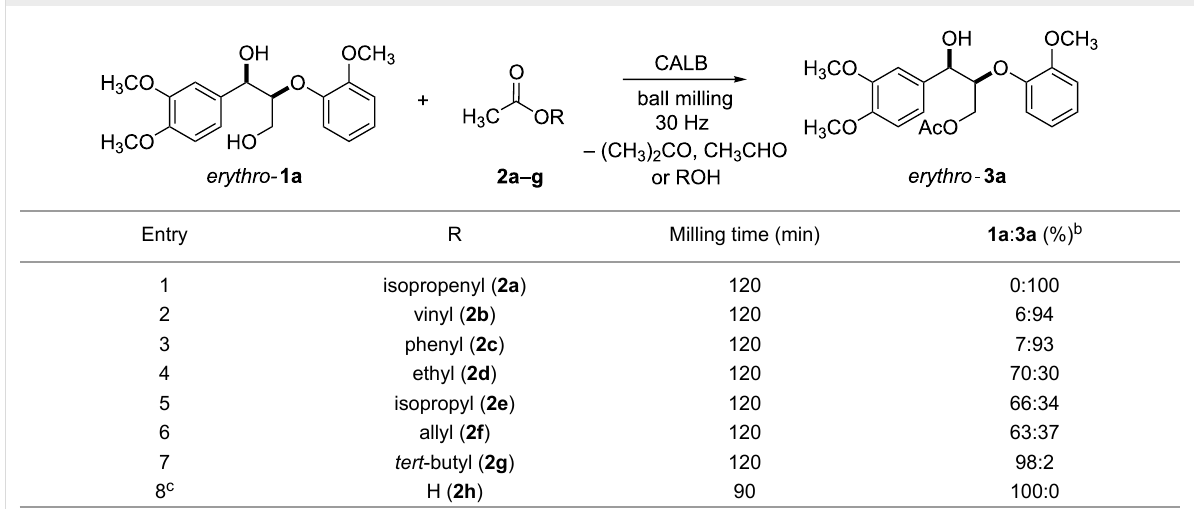
Table 2: Screening of acyl donors for the selective monoacetylation of dilignol erythro - 1a . a